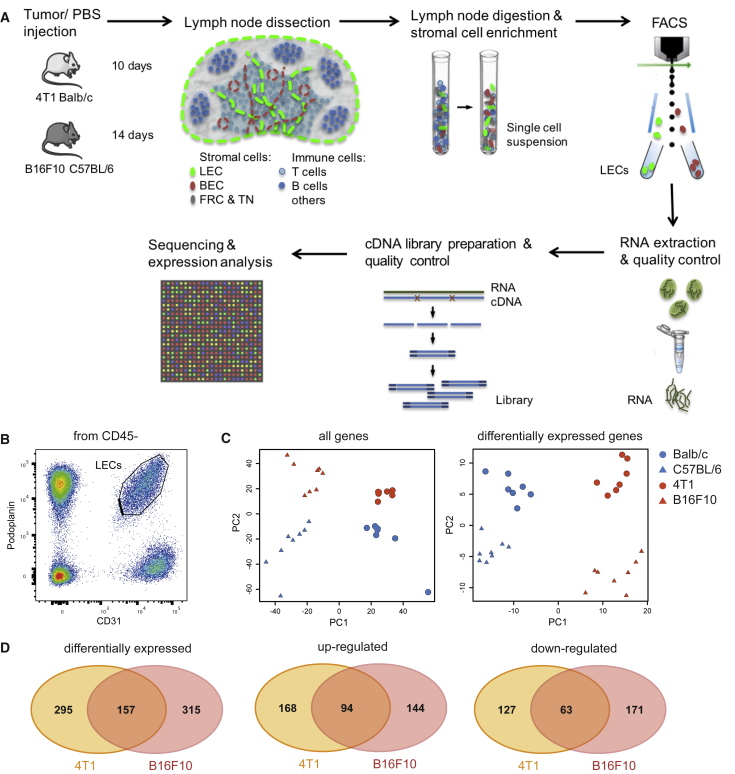
RNA Sequencing Reveals a Distinct Expression Profile of LECs from Tumor-Draining LNs(A) Schematic workflow for RNA sequencing of LN LECs.(B) Representative FACS plot showing the gating of LN LECs.(C) Principal-component analysis (PCA) of the sequenced LEC samples based on all genes (left) and differentially expressed genes (right).(D) Venn diagrams with the number of differentially expressed genes in LECs from tumor-draining LNs compared to naive in both tumor models.See also Figure S3 and Table S1.